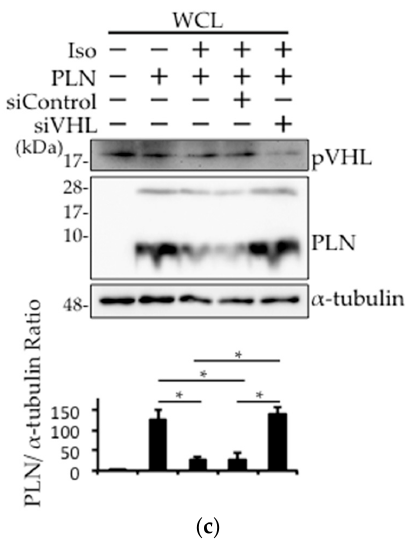
Figure 4. The expression of PLN is regulated by VHL. ( a , b ) VHL silencing or overexpression using siRNA or HA-VHL expression vector was performed in PLN-transfected HEK293 cells. The cells were harvested with ( b ) or without ( a ) 100 μ M H 2 O 2 treatment for 1 h. Western blot analysis was performed using antibodies against pVHL and PLN using whole cell lysates. The bar graph indicates the intensity of PLN bands, as measured by ImageJ ( n = 3). A value of p <0.05 (*) was considered significant. ( c ) VHL silencing was performed in PLN-transfected HEK293 cells. The cells were harvested 1 h after treatment with 1 μ M isoproterenol (Iso). Western blot analysis was performed using antibodies against pVHL and PLN using whole cell lysates. The bar graph indicates the intensity of PLN bands, as measured by ImageJ ( n = 3). A value of p <0.05 (*) was considered significant.